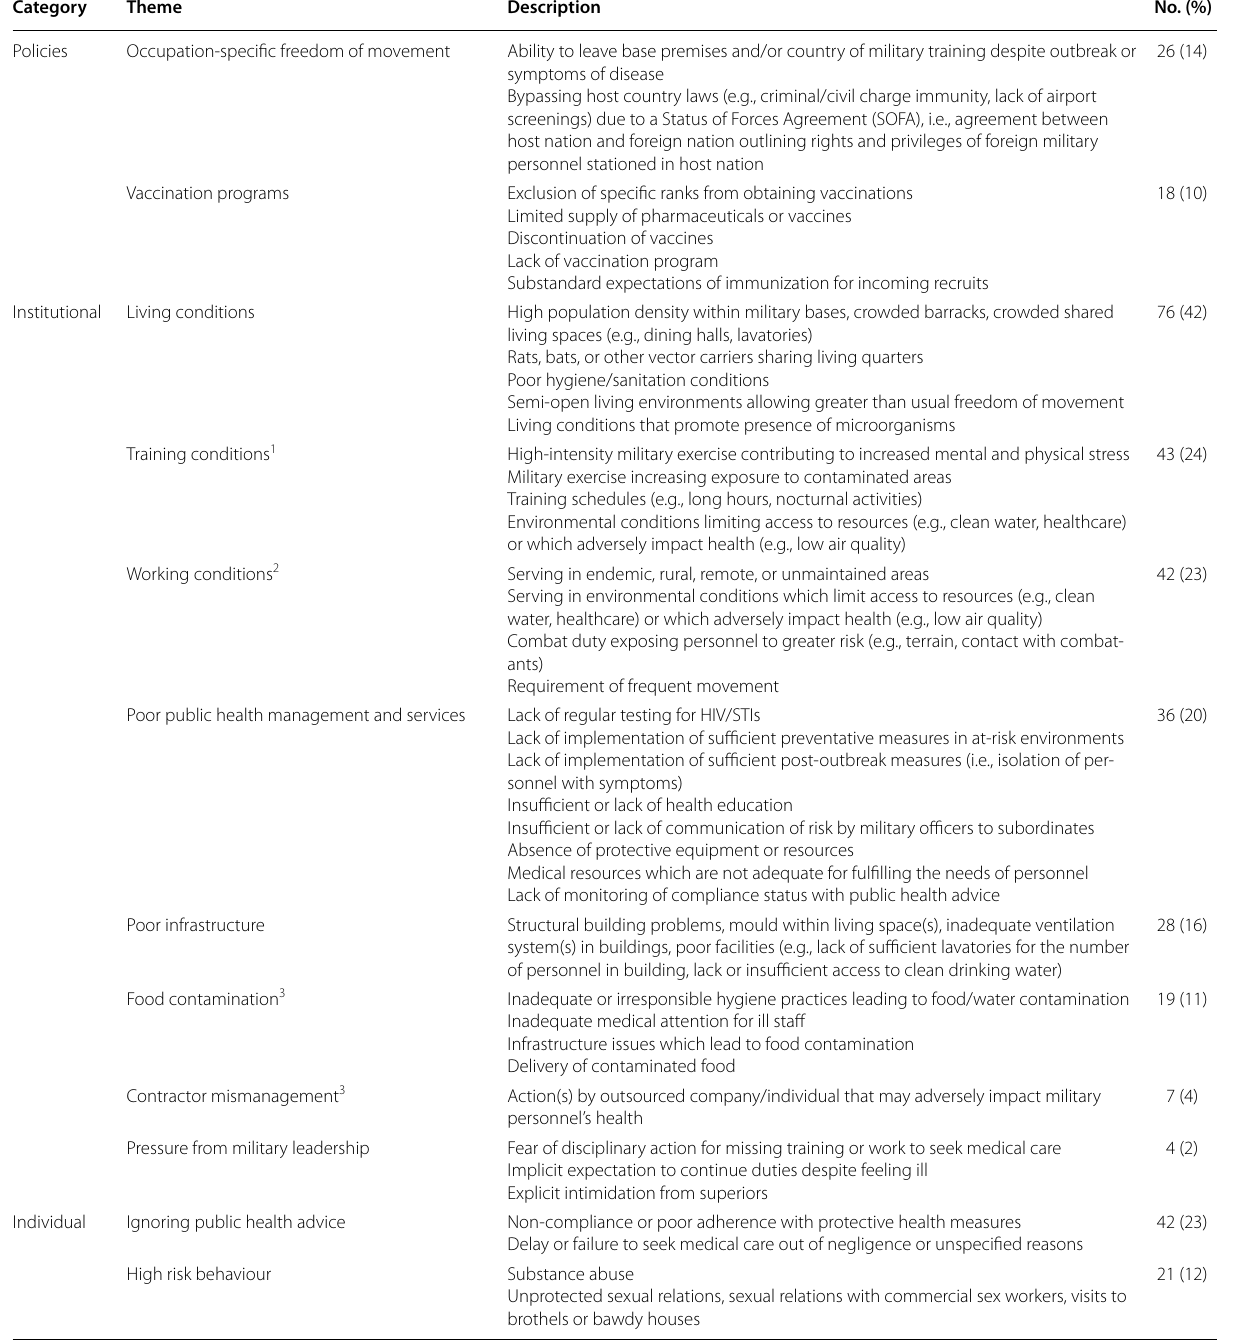
Table 2 Frequencies of Social Mechanisms of Transmission among included